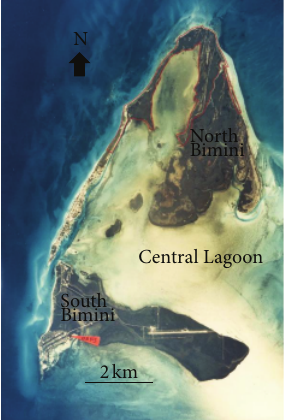
Figure 1: Aerial Photograph of the Bimini Islands with North Bimini above and South Bimini below encasing the study site, the shallow, sandy central lagoon.